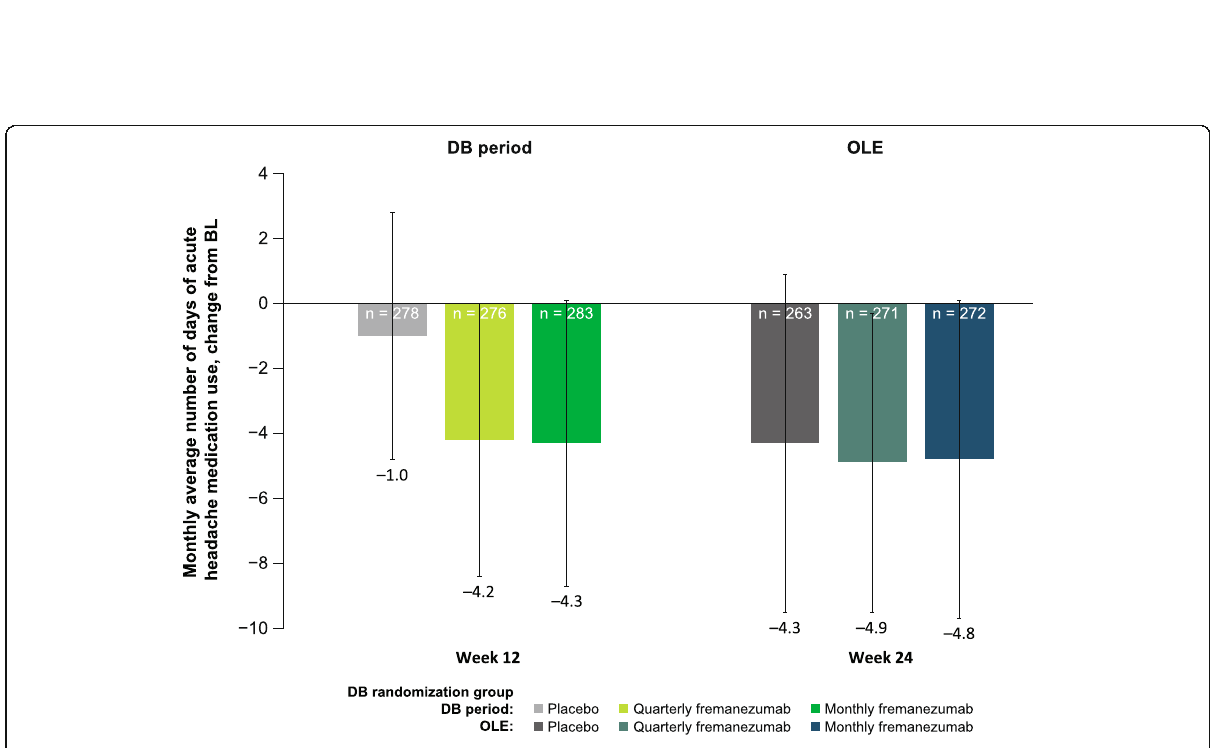
Fig. 6 Mean change from BL in days of acute headache medication use in the DB period and the OLE (mITT). a BL, baseline; DB, double-blind; OLE, open-label extension; mITT, modified intent-to-treat. a All patients in the OLE received fremanezumab 225 mg